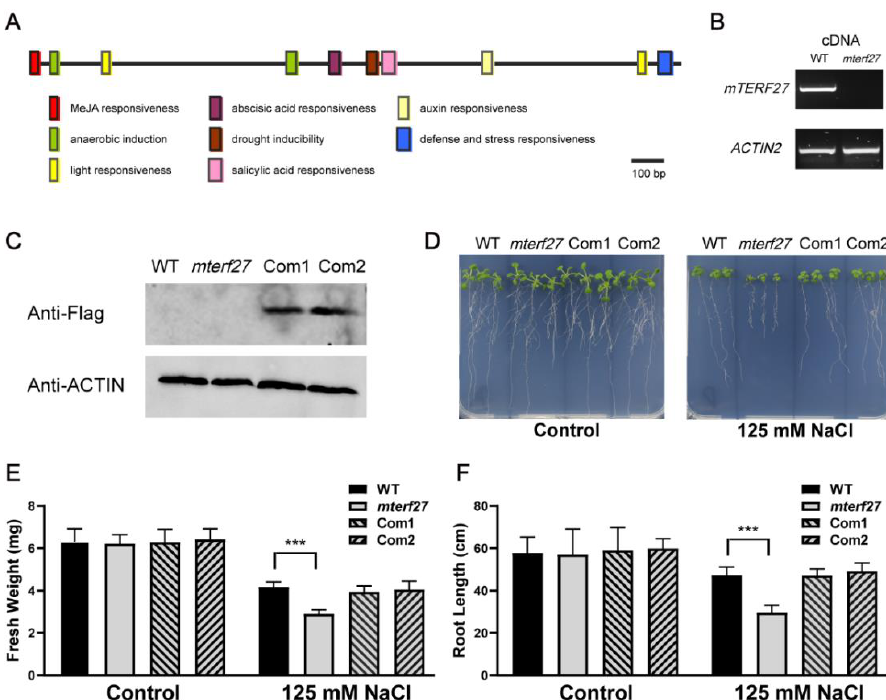
Figure 2. Identification of the Arabidopsis mterf27 mutant and phenotypes of WT and mterf27 seedlings under salt stress treatment. ( A ) Cis-acting regulatory elements of mTERF27 analyzed by PlantCARE. The bar represents 100 bp of nucleic acids. ( B ) PCR amplifications showing mTERF27 expression in WT and mterf27 plants. ACTIN2 was used as an internal control. cDNA, complementary DNA. ( C ) Western blots verifying mTERF27-Flag expression in mTERF27 -complemented lines (Com1 and Com2) based on total proteins extracted using the anti-Flag antibody. Anti- β -actin was used as internal control. ( D ) Fourteen-day-old WT, mterf27, Com1, and Com2 plants grown for 10 days in either 1/2 MS medium (Control) or 1/2 MS medium supplemented with 125 mM NaCl. ( E ) Fresh weights and ( F ) root lengths of the WT, mterf27 , Com1, and Com2 plants shown in Figure 2D. Data shown are means ± SD of three independent experiments. Asterisks show significant differences compared to the WT: ***, p < 0.001 (Student’s t